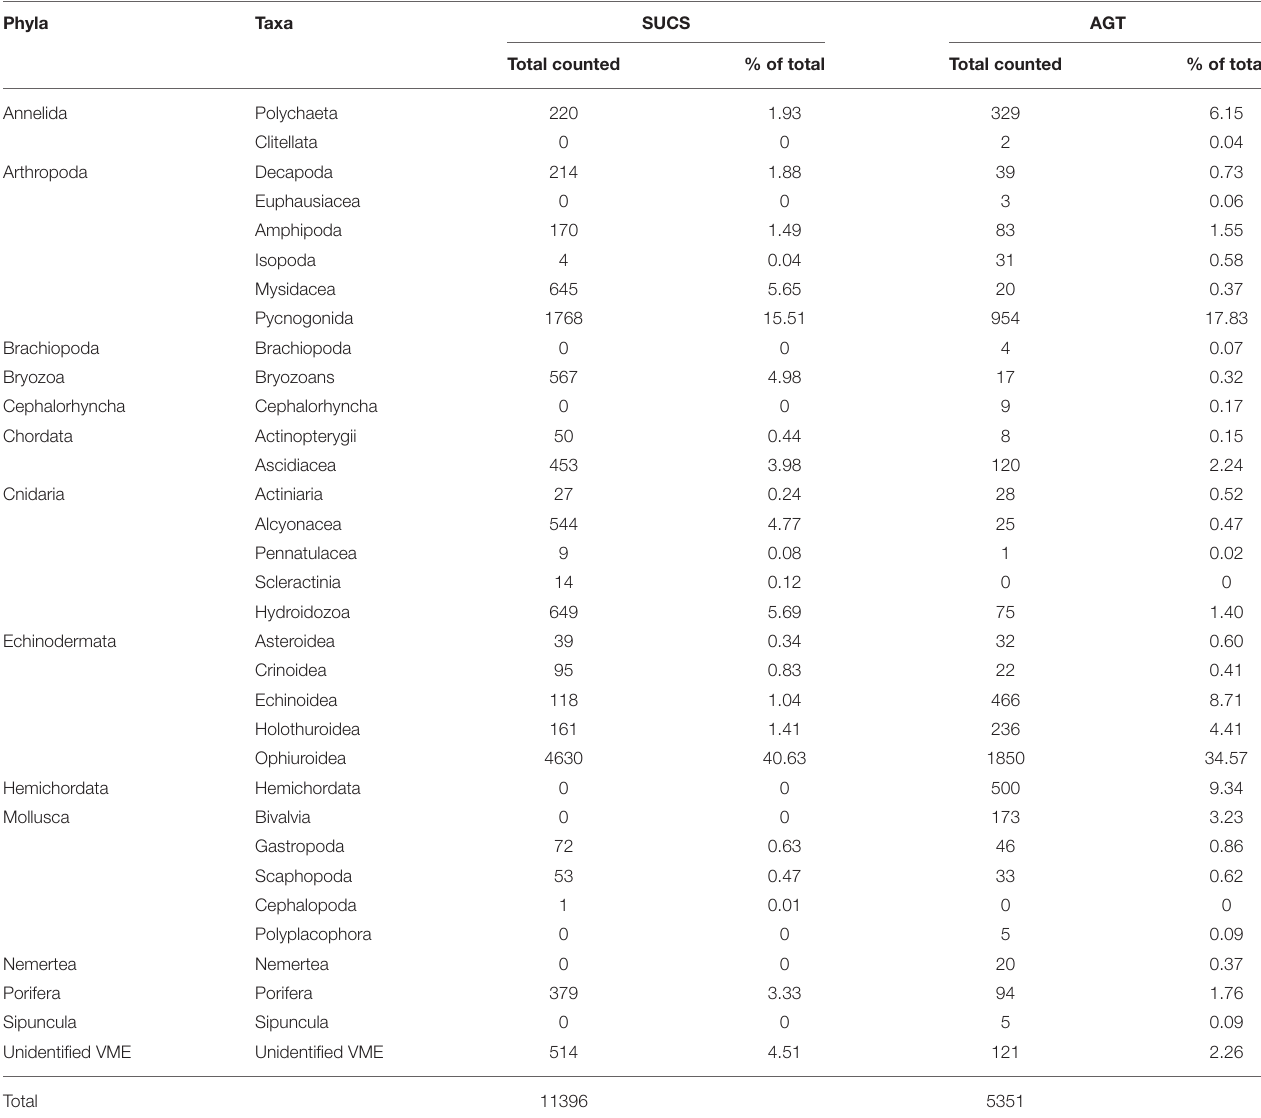
TABLE 3 | All taxa observed and identified from SUCS imagery and AGT, including relative proportion of total observation/catch.